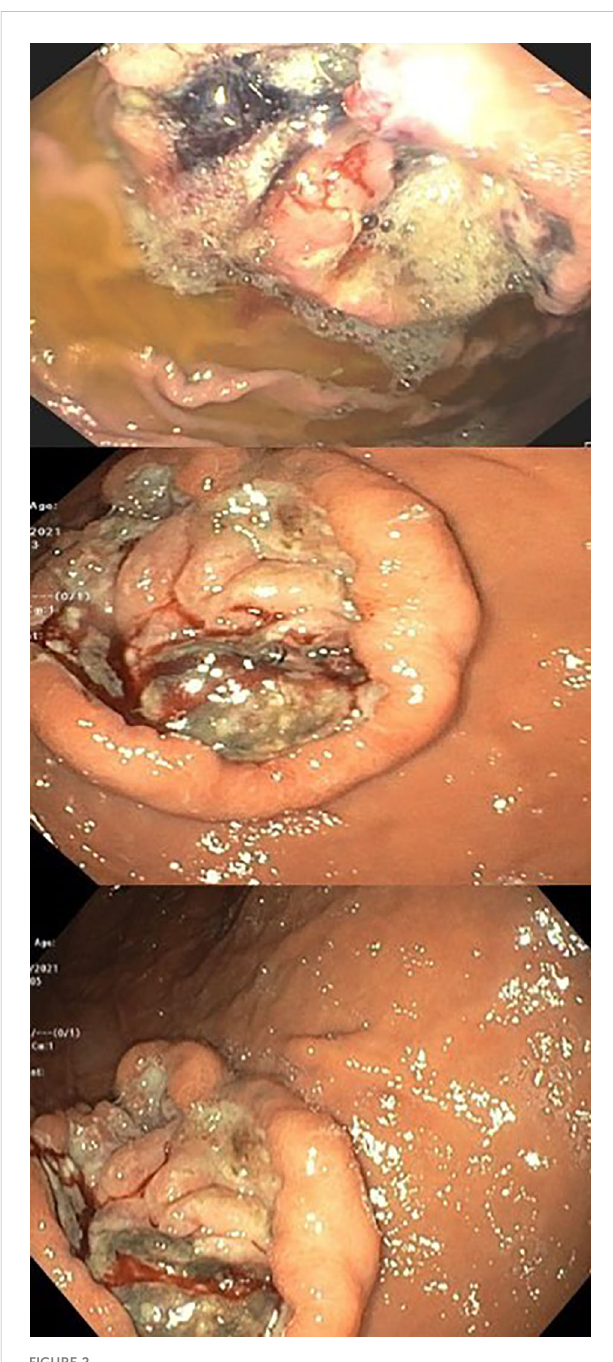
FIGURE 2 Pictures that were taken during gastroscopy which showing the active